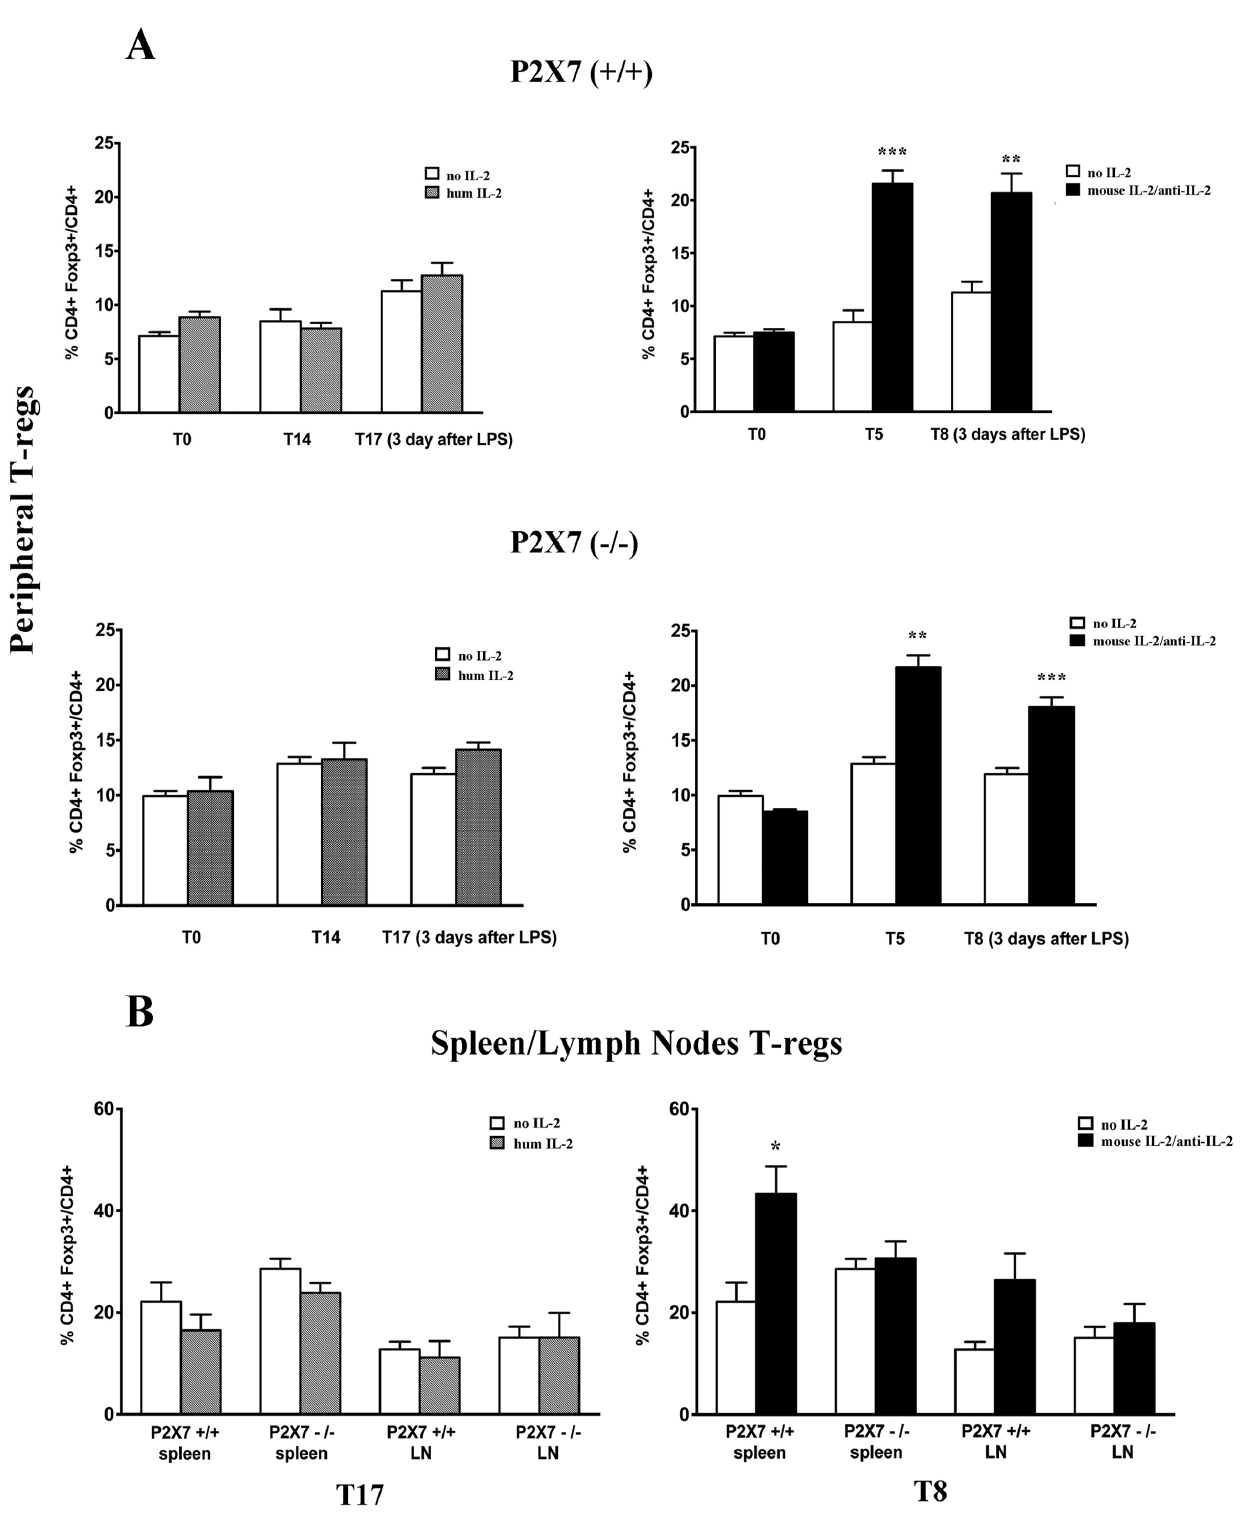
Figure 3. Treg level regulation by IL-2 and IL-2/anti-IL-2. Peripheral (A) and spleen/lymph nodes (B) Tregs levels were evaluated at several intervals after IL-2 and IL-2/anti-IL-2 treatment and after LPS in both WT and P2 6 7 2 / 2 mice. In the case of IL-2, determination of circulating and tissue Tregs was done after 7 and 14 days from IL-2 that is the time potentially required to achieve a regulatory effect of the cytokine [21].; Tregs were also determined 3 days after LPS that means 17 days from IL-2 treatment. The time required for a regulatory effect of IL-2/anti-IL-2 is instead 5 days. Treg levels were accordingly determined at this time (i.e. 5 days after IL-2/anti-IL-2) and after 3 days from LPS corresponding to 8 days of treatment. *=p # 0.05, **=p # 0.005, ***=p # 0.0005.